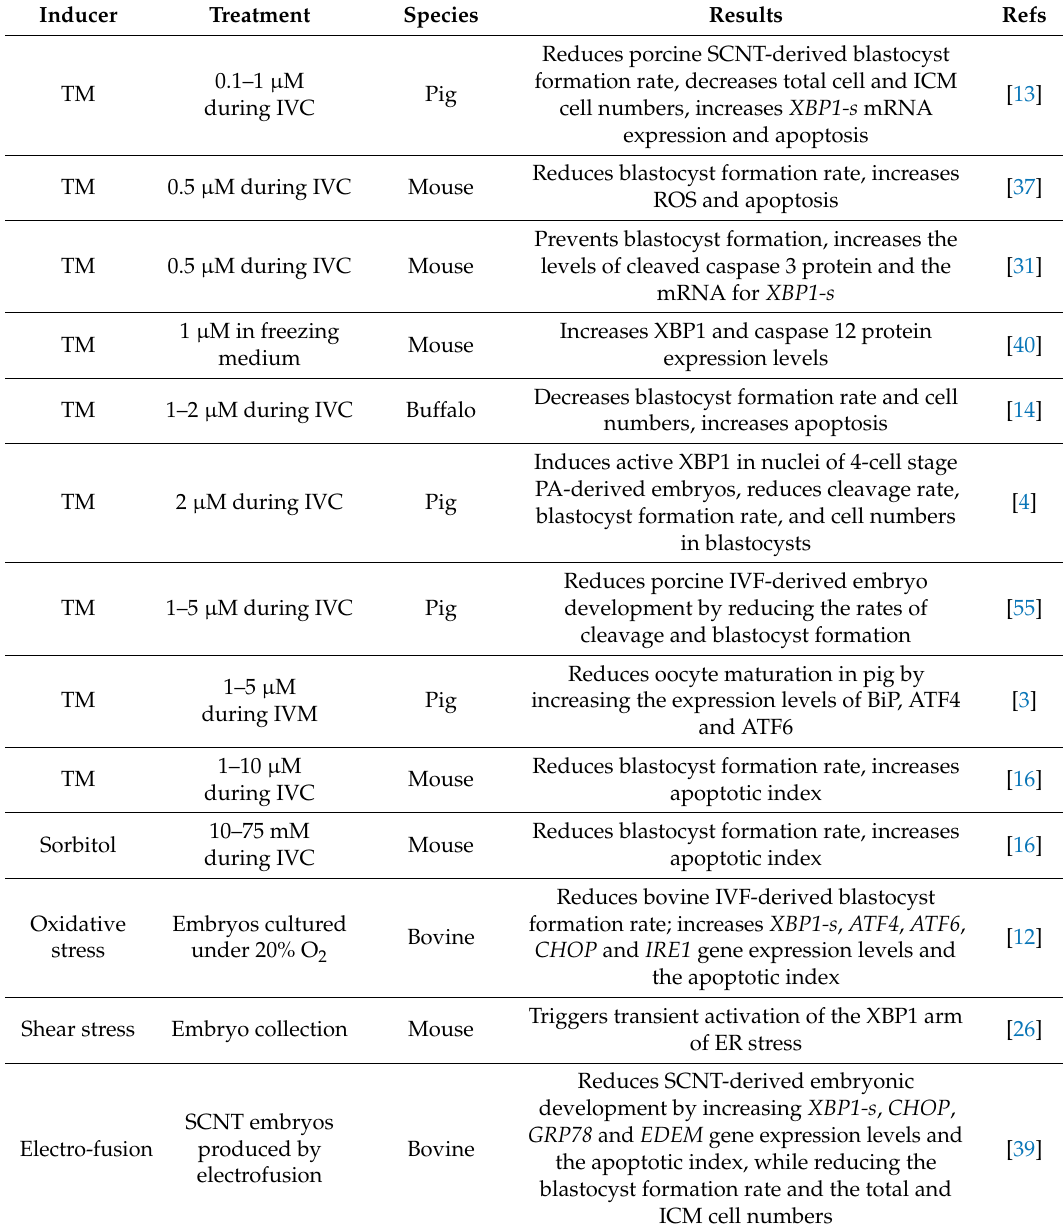
Table 2. The impact of endoplasmic reticulum stress inducers on mammalian oocyte maturation and embryo